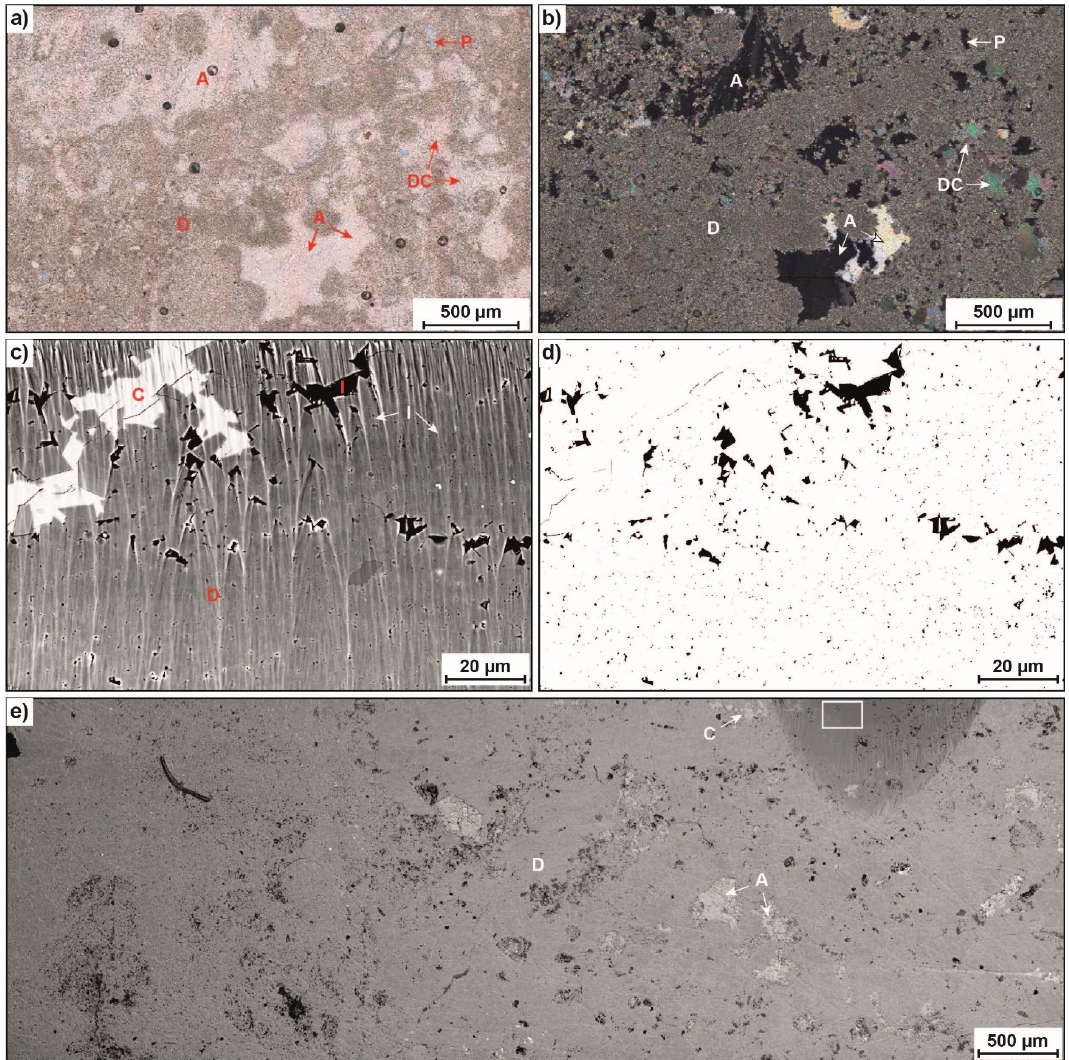
Figure 4. Petrographic observations of dolowackestone backshoal sample 213. Thin-section images ( a ) (plane-polarized) and ( b ) (cross-polarized) show pores (P), mainly caused by dissolution of patchy and heterogeneously distributed displacive anhydrite (A), which are partly closed by dolomite cements (DC). Allochems are recognizable but cannot be distinguished due to dolomitization as a diagenetic overprint. ( c ) High resolution BSE-SEM image stitched from 255 single images. Compared to the thin-section images, not only macro- and mesopores but also (intercrystalline (I)) micro- and nanopores, hosted by aphanocrystalline matrix dolomite (D), and calcite cements (C) are visible. Further, intracrystalline pores, probably fluid inclusions, are apparent inside the fine to medium crystalline dolomites. ( d ) Binarized version of high-resolution image ( c ) used for image analysis (Figure 7a). ( e ) Large scale mosaic stitched from 243 images. The position of detailed images ( c ) and ( d ) is indicated within the broad ion beam (BIB)-polished